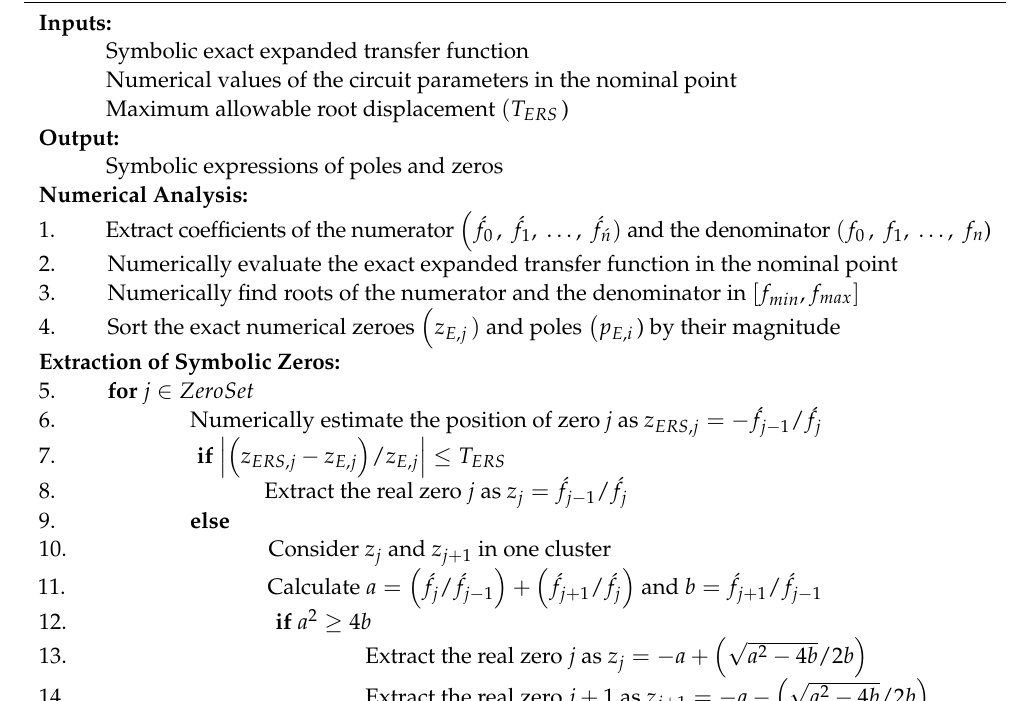
Algorithm 1. Symbolic Pole/Zero Extraction using